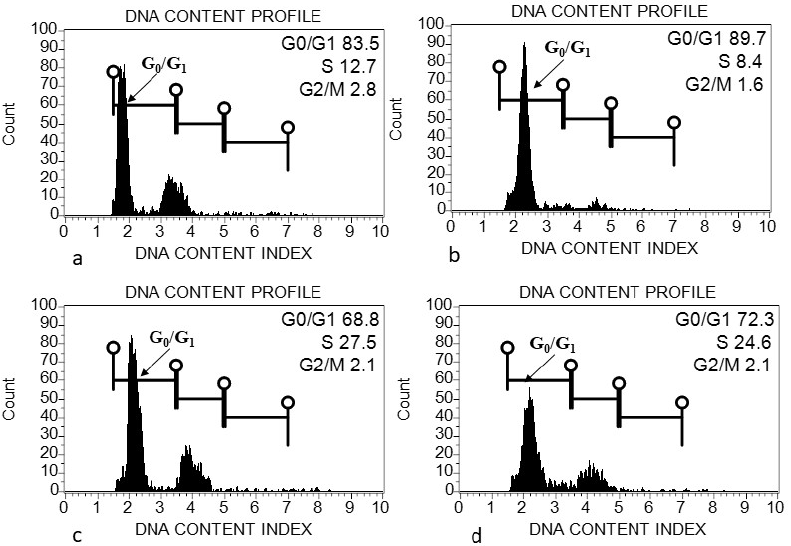
Figure 3. Flow cytometry (FCM) histograms of propidium iodide (PI) fluorescence intensity of nuclei prepared from cotyledon of Acacia johnwoodii using different extraction buffers. ( a ) Galbraith’s